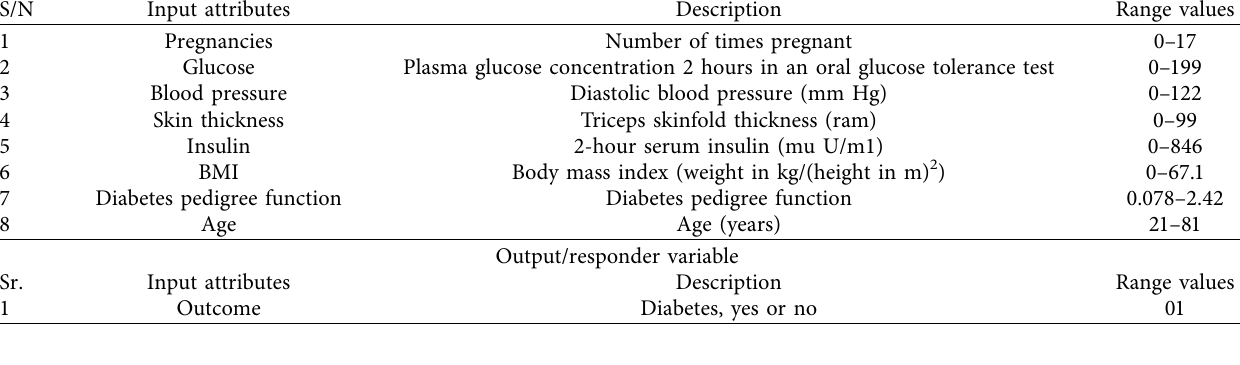
Table 1: The input and output variables for the proposed system